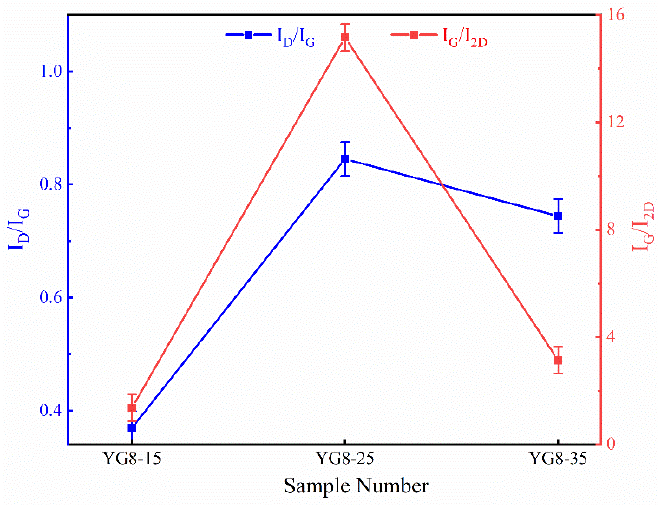
Figure 4. The I D / I G , I G / I 2D value at different cooling rates.